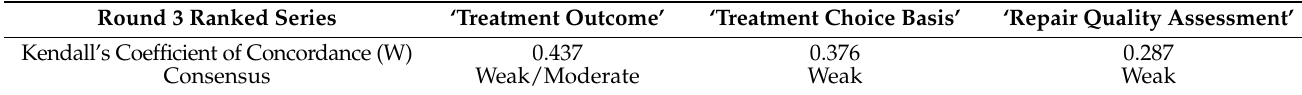
Table 6. A summary of the consensus results for the ranked series in round 3. None of the ranked series showed consensus in round 3. Note that the ‘Tissue type’ rank was removed as this series reached consensus in the previous round.